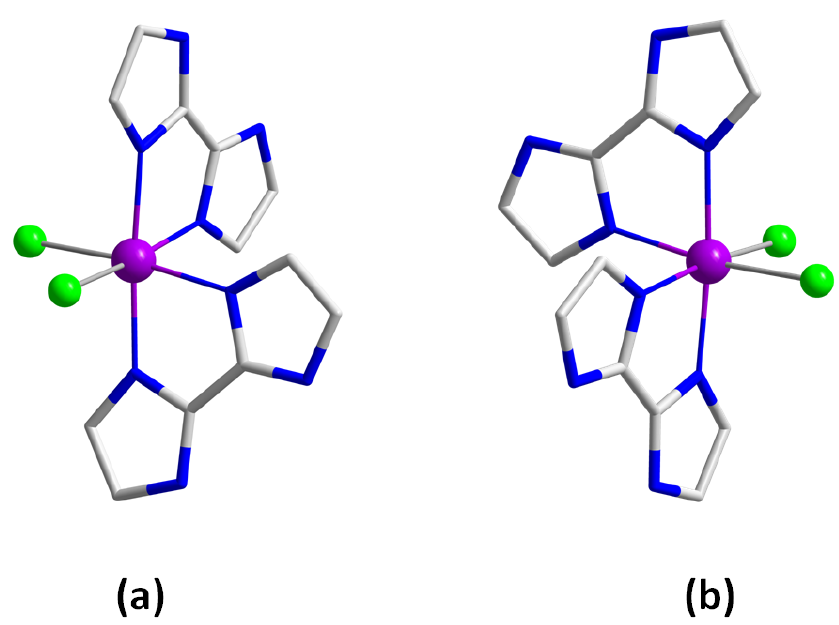
Figure 1. ( a ) Molecular structure of the mononuclear (inactive) isomer 1 of the {cis-[RuCl 2 (H 2 biim) 2 ]Cl} 2 · 4H 2 O racemic mixture in Runat-BI. ( b ) Molecular structure of the mononuclear isomer 2 of the {cis-[RuCl 2 (H 2 biim) 2 ]Cl} 2 · 4H 2 O racemic mixture in Runat-BI. Water molecules, hydrogen atoms and chloride counter anions were omitted for clarity.